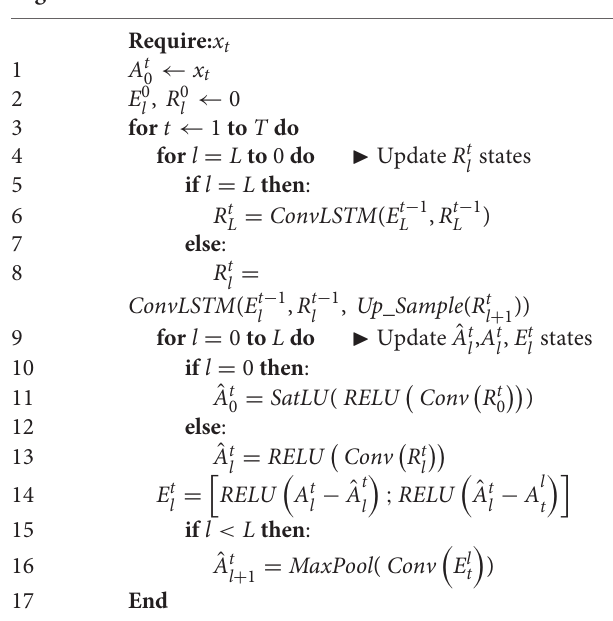
Algorithm 1: Calculation of PredNet States